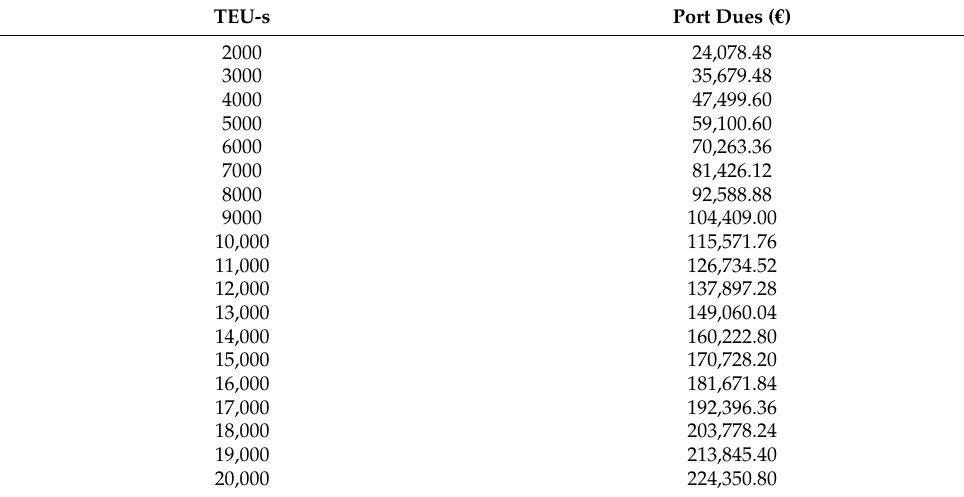
Table A1. Port duties at the port of Rotterdam in €